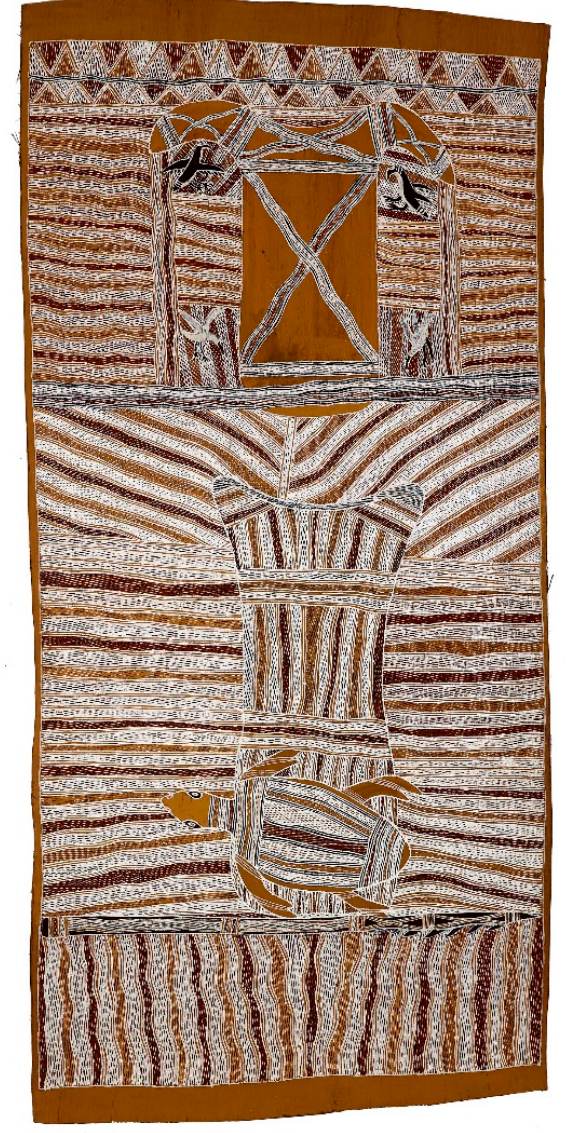
Figure 2. (Australian National Maritime Museum 2018), Djambawa Marawili, Mangalili Yindiwir-